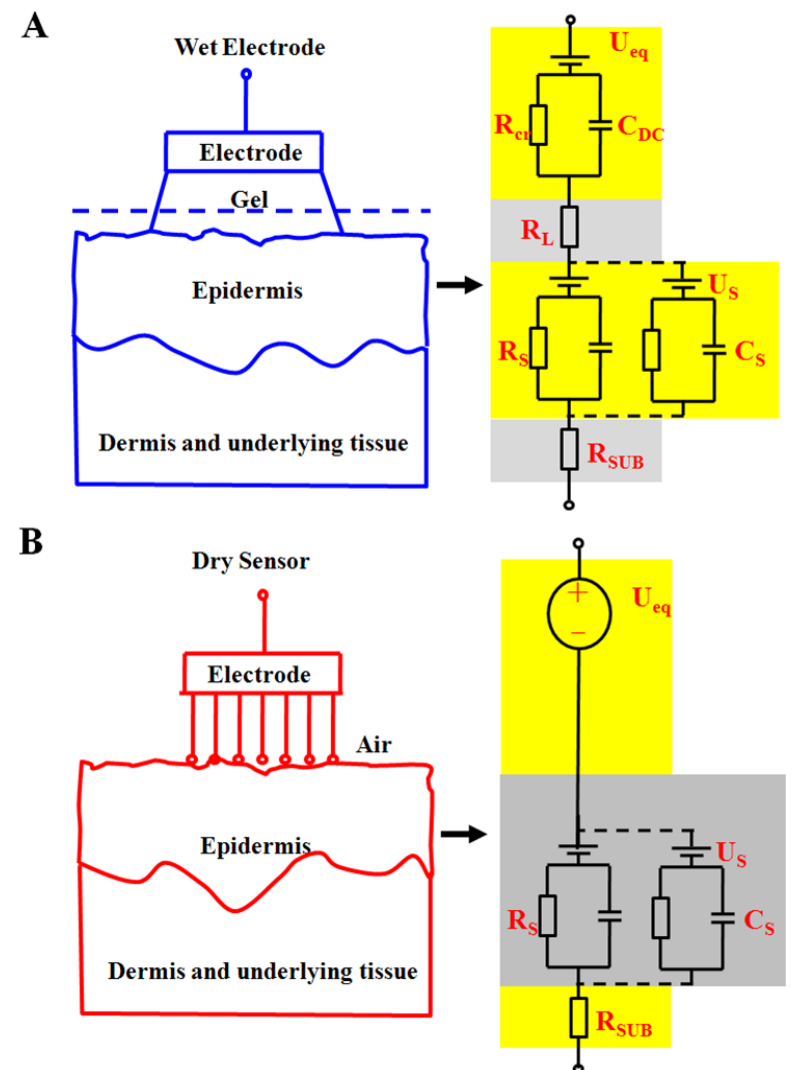
Figure 3. The equivalent circuits of ( A ) a wet electrode-skin interface and ( B ) a dry skin-sensor